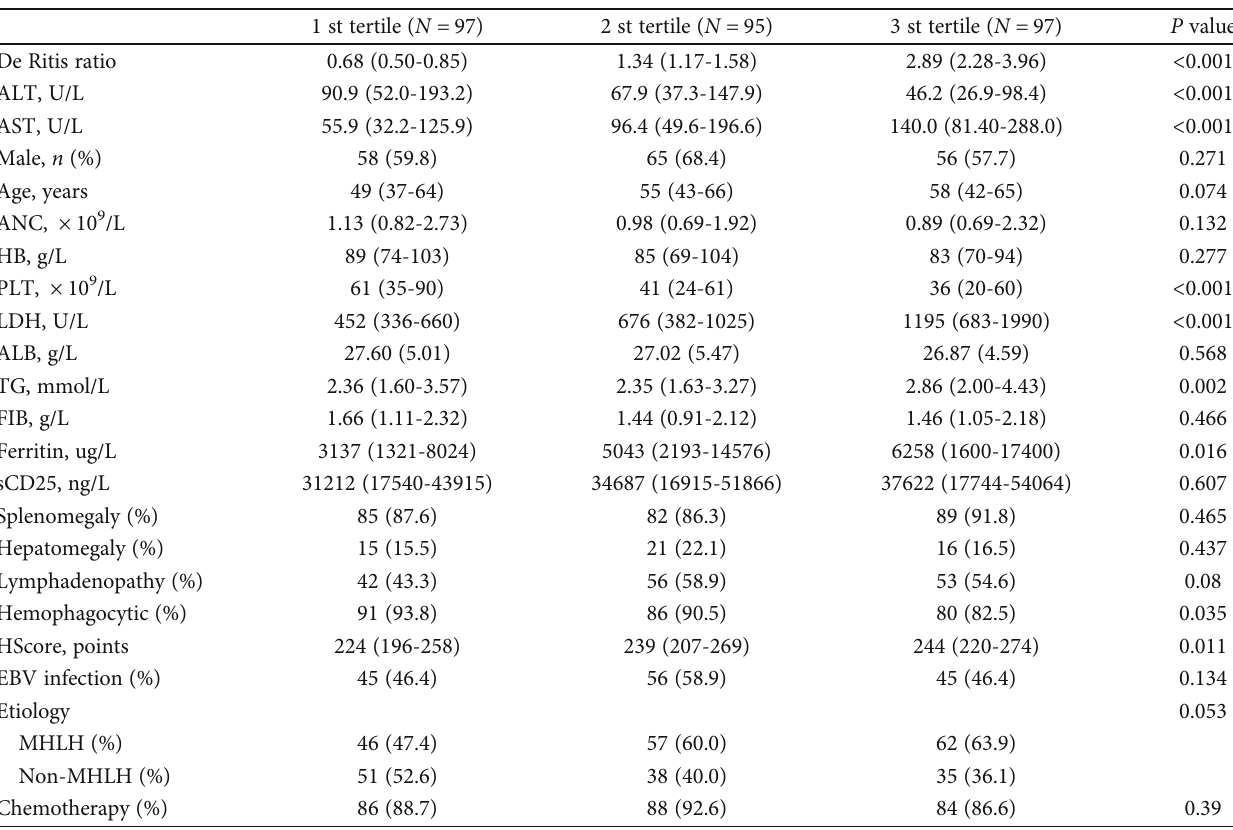
Figure 1: Consort diagram of enrolled patients. sHLH: secondary hemophagocytic lymphohistiocytosis. Table 1: Baseline demographic, clinical, and laboratory characteristics of the study patients according to tertiles of AST/ALT (De-Ritis